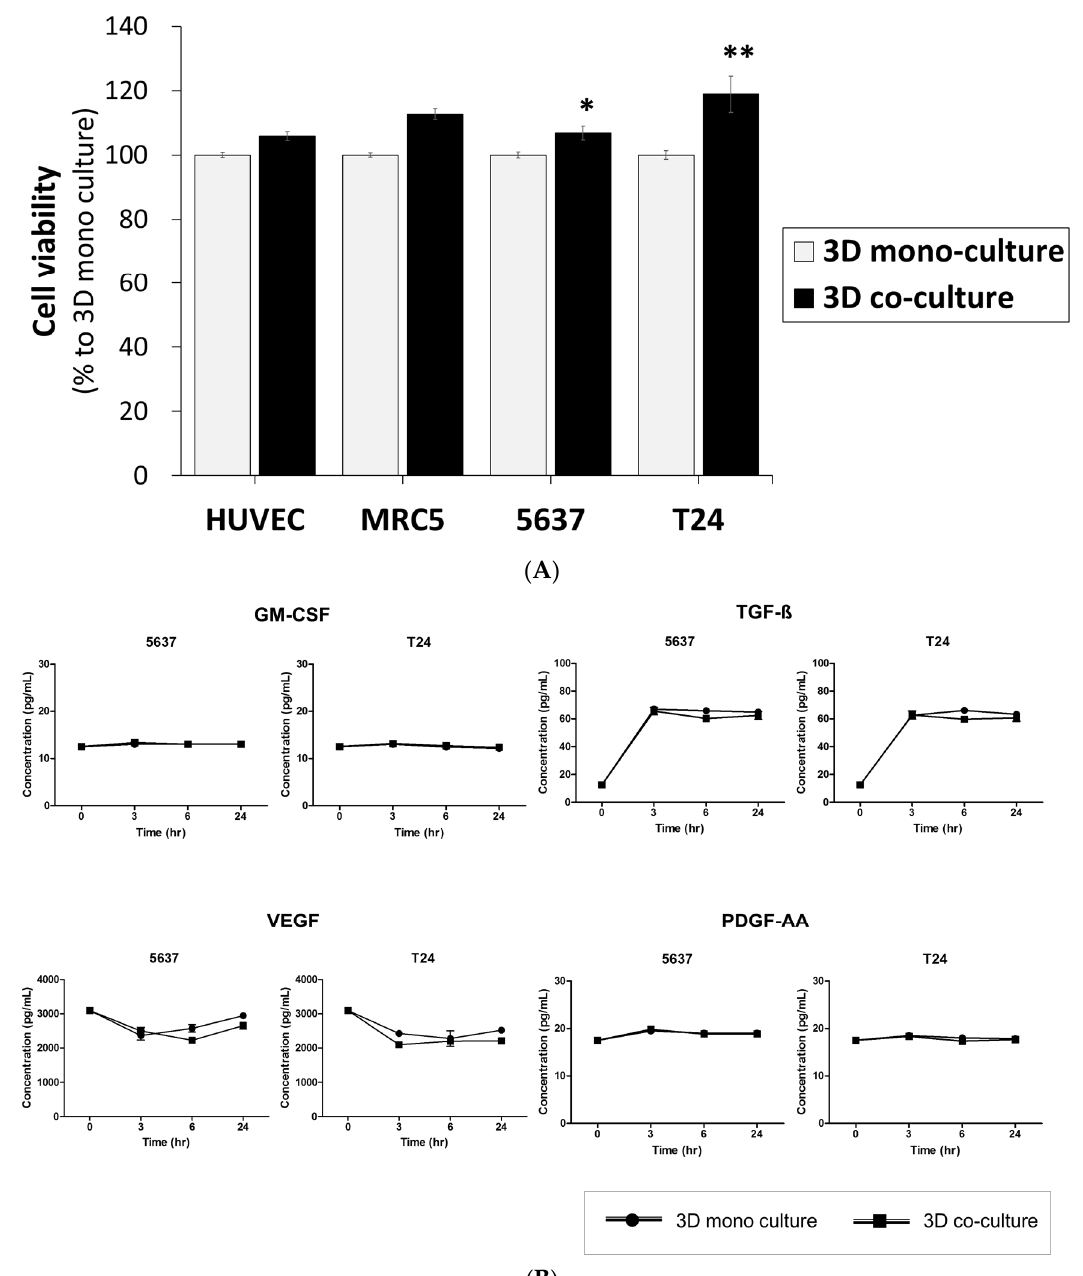
Figure 4. Viability of cells in printed constructs and comparison of 3D mono- and co-culture. ( A ) the viability of the bladder cancer cells in 3D mono- and co-culture; ( B ) growth factors concentrations in 3D mono- and co-culture. Data are the mean ± SE of the mean ( n = 3, per group). * p < 0.05, ** p < 0.01. SE: standard error.